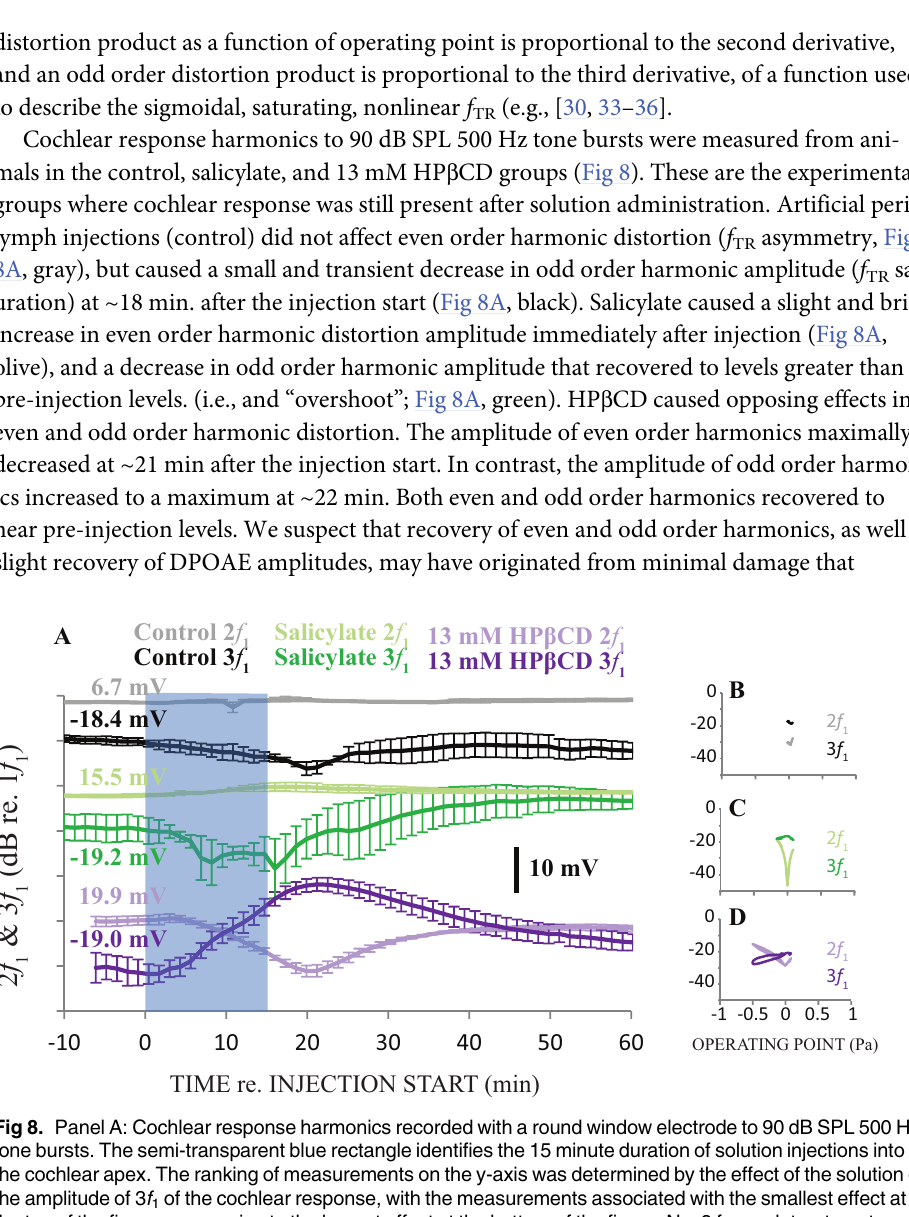
Fig 7. Organ of Corti histology from each of the four cochlear turns of one exemplar guinea pig ears after apical injection of 27 mM HP β CD. Damage was greater in the cochlear base that is tuned to high frequencies.